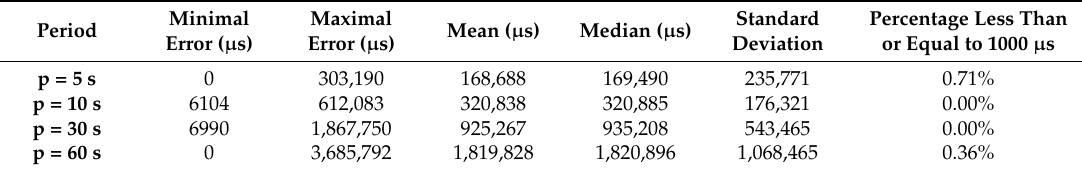
Table 4. Results obtained in the precision experiment using the LSI as clock source, simulating a clock synchronization process.